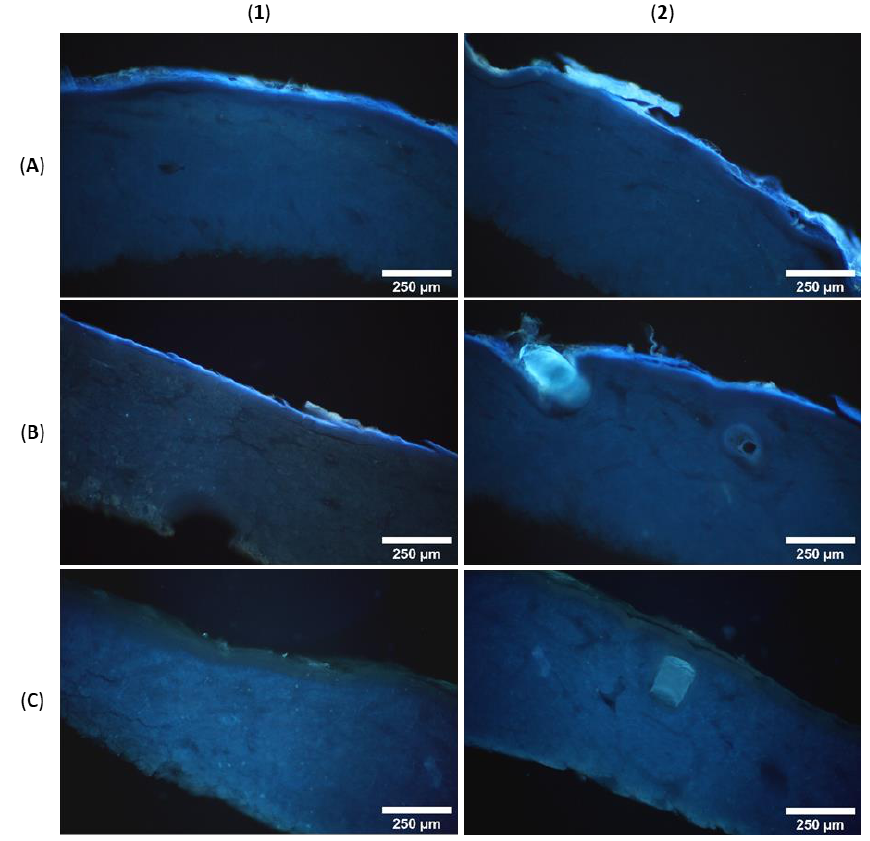
Figure 5. Fluorescence microscopic images of minipig skin after treatment with H-DMCA ( A , B ) and control skin ( C ).